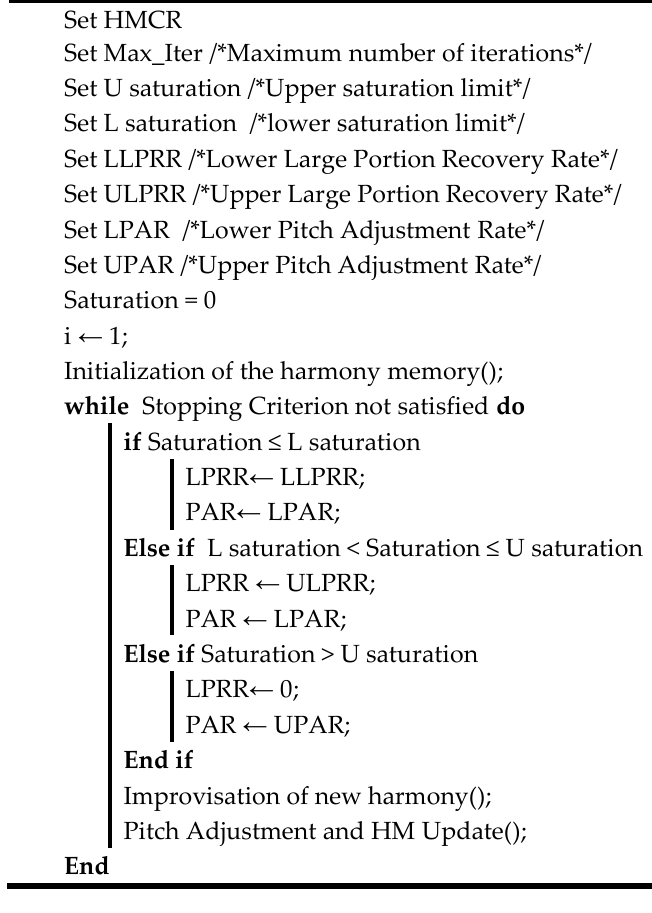
Figure 2. Parameters initialization algorithm.